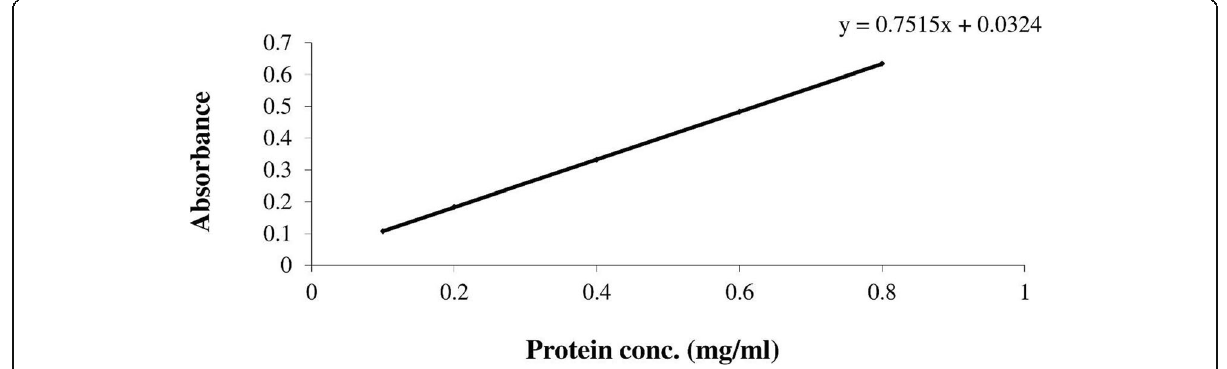
Fig. 1 Calibration curve for